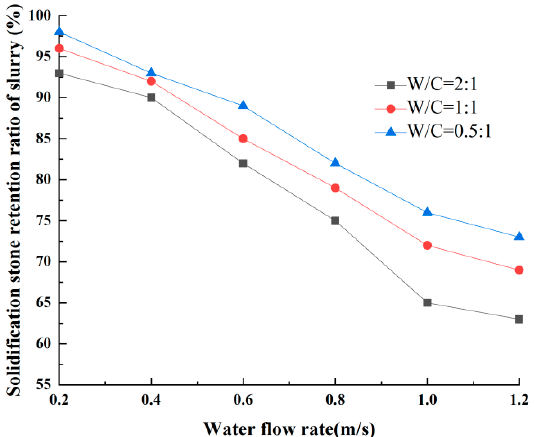
Figure 5. Stone solidification retention ratio of slurry in moving water environment.